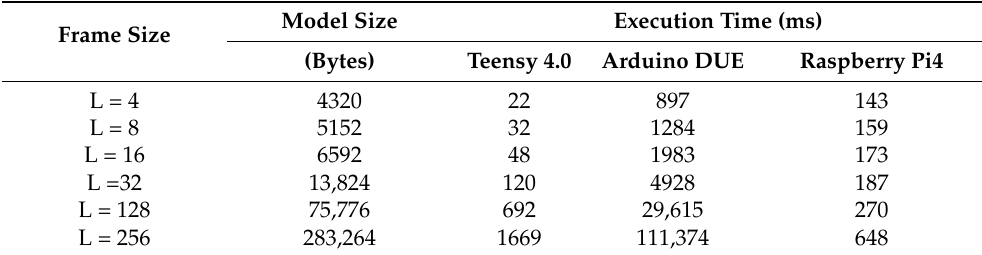
Table 8. Model performance on Teensy 4.0 MCU, Arduino DUE and Raspberry